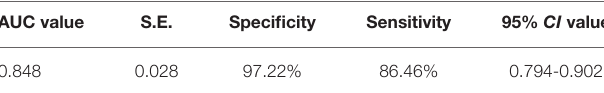
TABLE 2 | Comparison of the coincidence rate, specificity and sensitivity of early warning score diagnosis.